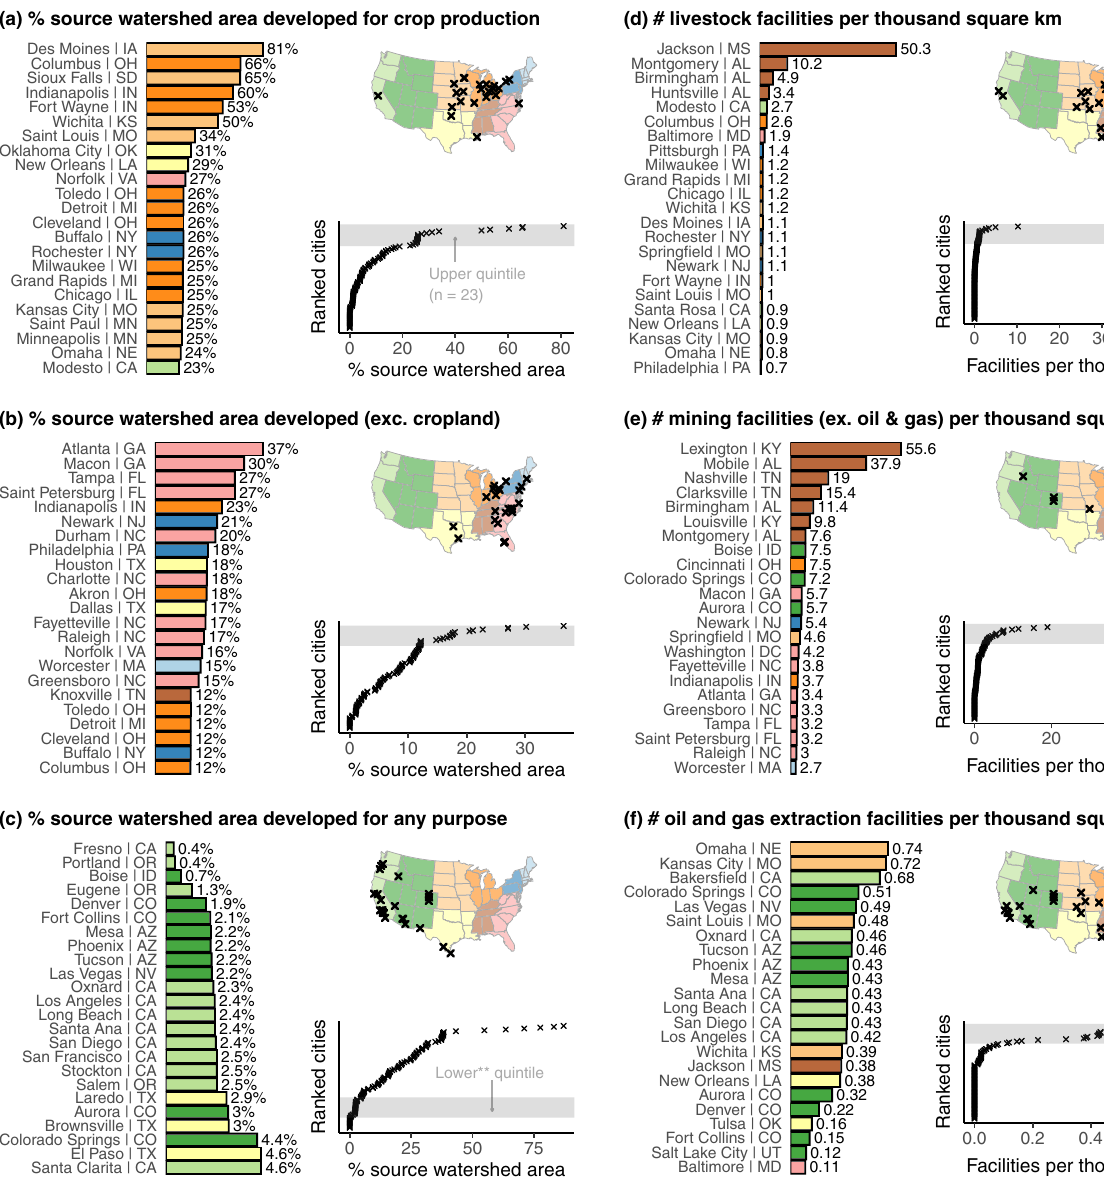
Fig. 4 Regional hotspots of land use pressure. Presence of land development by % watershed area upstream of city water supply intakes ( a – c ) and number of facilities registered with National Pollutant Discharge Elimination System of the U.S. Environmental Protection Agency in those watershed areas ( e , f ). In each panel, the cities highlighted in the map and bar chart correspond to cities of the quantile shaded in the distribution plots. This is the upper quintile (80th percentile and above) for all panels except ( c ), which highlights the lower quantile. **Lower quantile excludes groundwater-only cities ( n = 12). Bar color is by U.S. Census division (illustrated in each